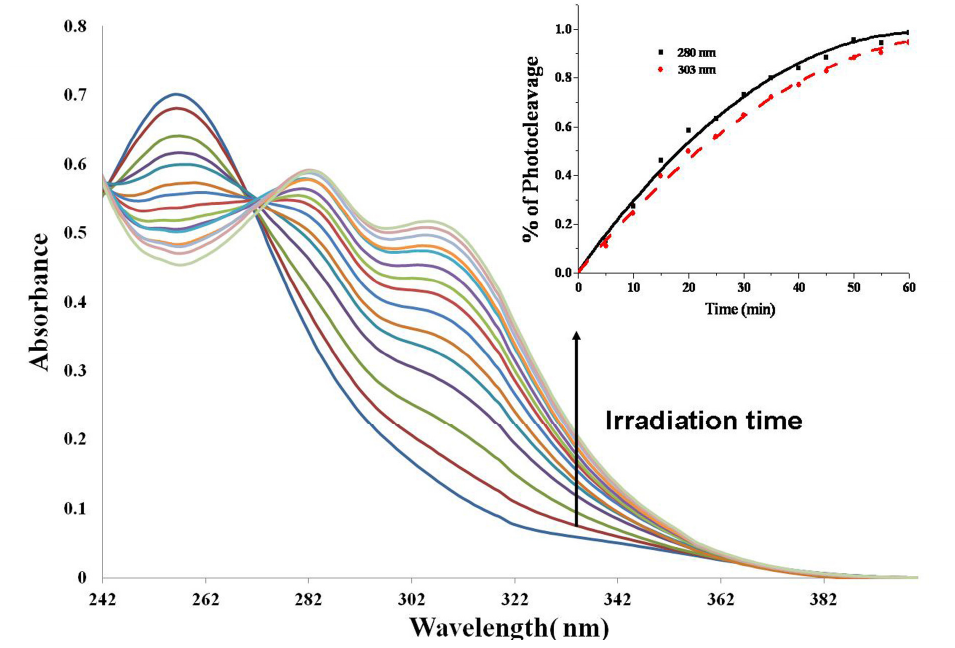
Figure 1. UV-Vis absorbance spectra of polymer P3 upon photolysis at 365 nm (50 μ